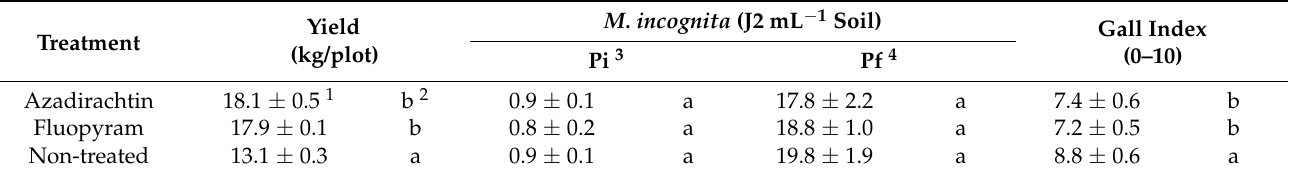
Table 2. Effect of treatments with azadirachtin and fluopyram on the control of Meloidogyne incognita on tomato and on crop yield, 120 days after